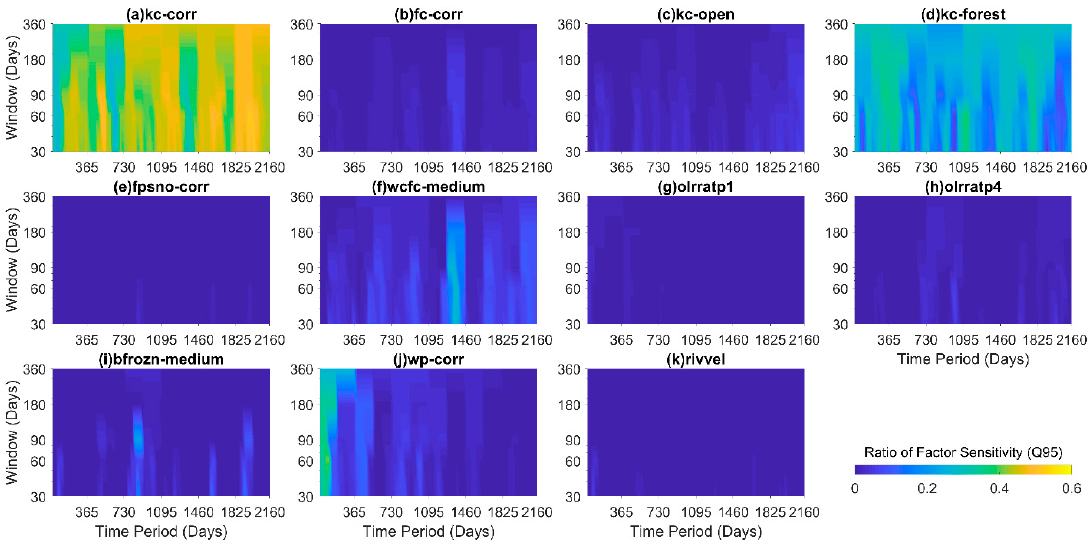
Figure 11. Ratio of factor sensitivity for moving windows of 30 days, 60 days, 90 days, 180 days and 360 days using 3-day averaged Q 95 (low flow) as the evaluation criteria from 01/01/2000 to 29/11/2005.